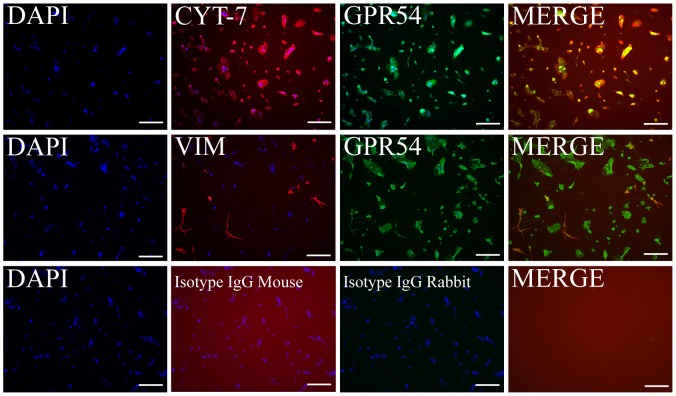
Characterization of primary cultures of first trimester trophoblast cells.Staining of primary cultures of isolated first trimester trophoblast cells. Top row, staining with DAPI (blue) which labels cell nuclei, anti-cytokeratin-7 (CYT-7, red), anti-GPR54 (green) and the merge of staining with anti-cytokeratin-7 (red) and anti-GPR54 (green). Middle row, staining with DAPI (blue), anti-vimentin (VIM, red), anti-GPR54 (green) and the merge of staining with anti-vimentin (red) and anti-GPR54 (green). Bottom row, staining with DAPI (blue), isotype matched mouse and rabbit IgG as negative controls and their merge. Scale bar indicates 200 µm.